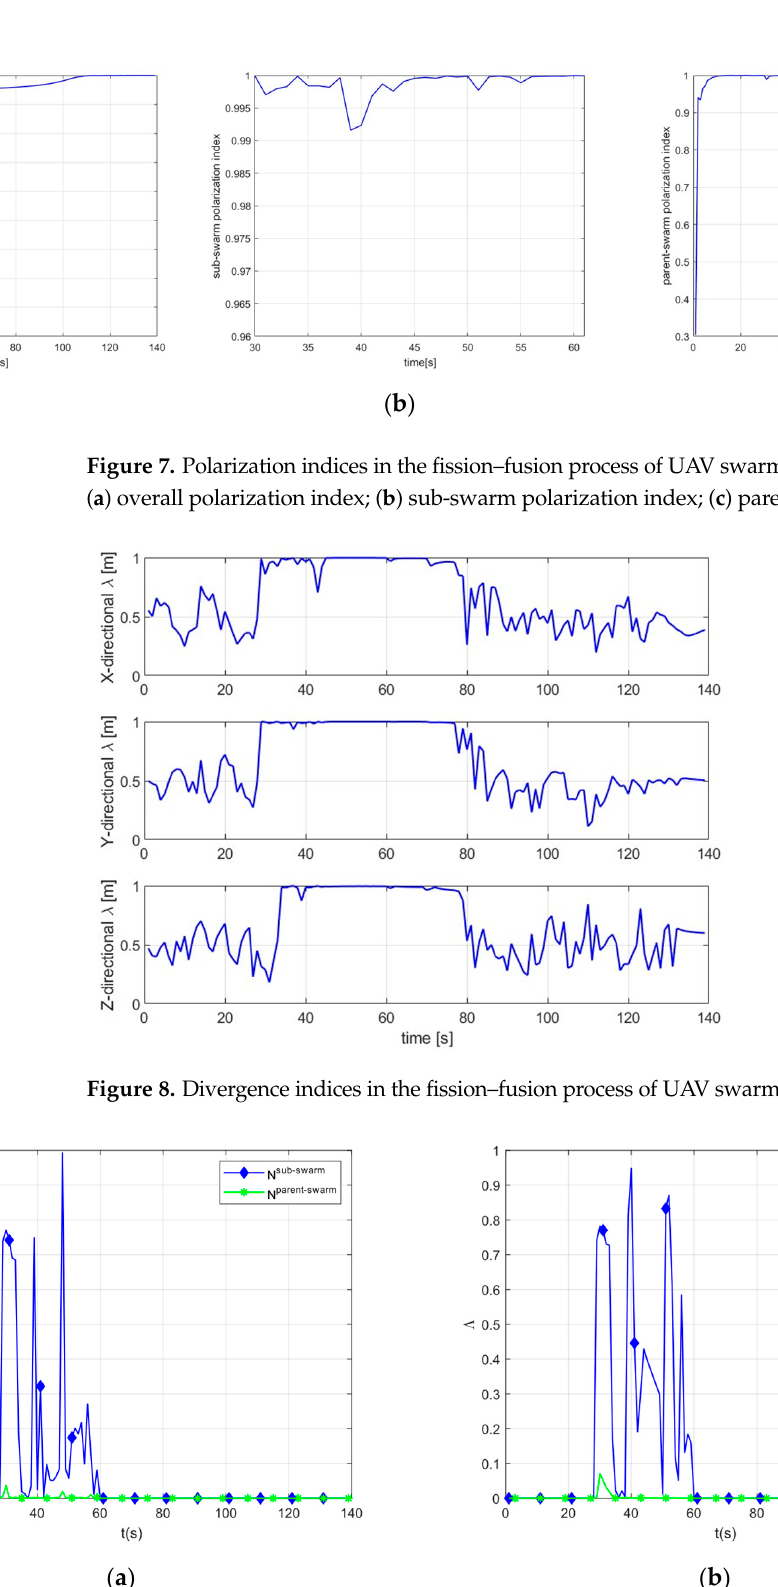
Figure 9. Precision of response stimuli of sub-swarm and parent swarm in two cases. ( a ) the precision of response stimuli without backpatch; ( b ) the precision of response stimuli with backpatch.